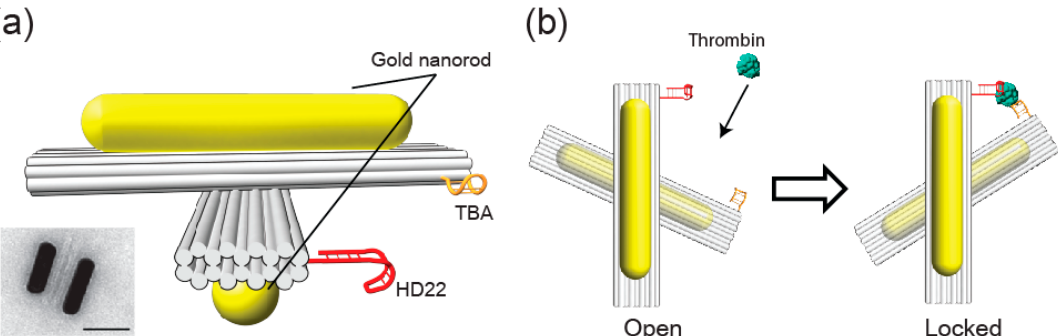
Figure 1. Scheme for human α -thrombin sensing with the plasmonic metamolecule. ( a ) The structure consists of two 10-helix bundles each carrying two a gold nanorods (AuNRs) at the top and bottom respectively. The arms are connected by a single-stranded DNA linker (not shown) and are modified at one of their ends with one thrombin aptamer each—thrombin-binding aptamer (TBA) and HD22. Inset: TEM image of an assembled structure lying on its side (Scale bar: 50 nm). ( b ) In the absence of thrombin, the structure is in its ‘open’ state. In the presence of thrombin, the two aptamers can sandwich one target molecule to fix the structure in its ‘locked’ state with defined right-handed chirality.